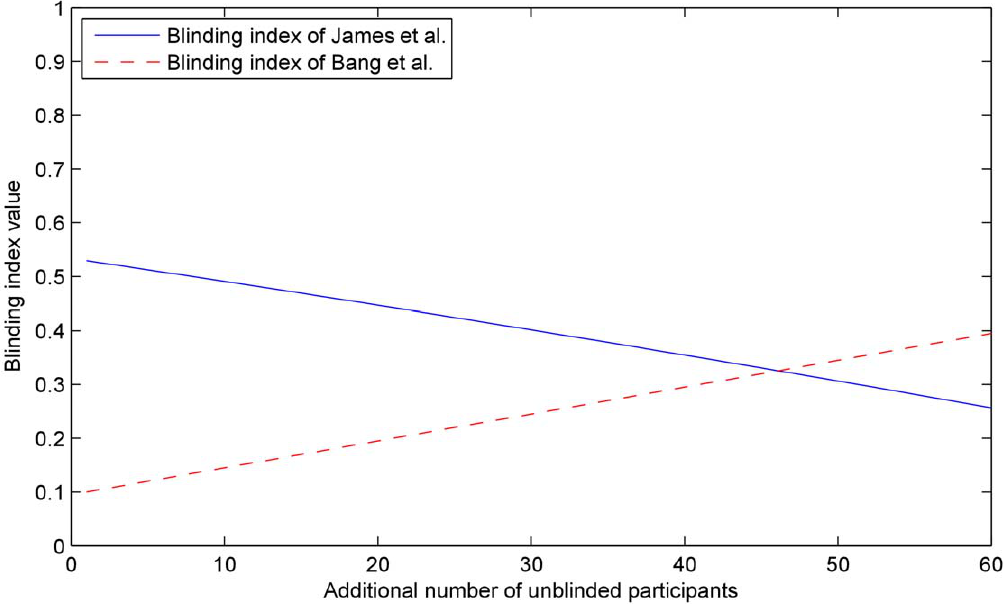
Figure 8. Experiment 3. The values of the blinding indexes proposed by James et al. (blue line) and Bang et al. ( red line), computed at each step of the progressive unblinding of the participants assigned to the treatment group. As expected, both indexes dramatically change in value and in this case agree that the level of blinding in the trial has decreased. Compare this with the robustness of the proposed approach in Figure 7.